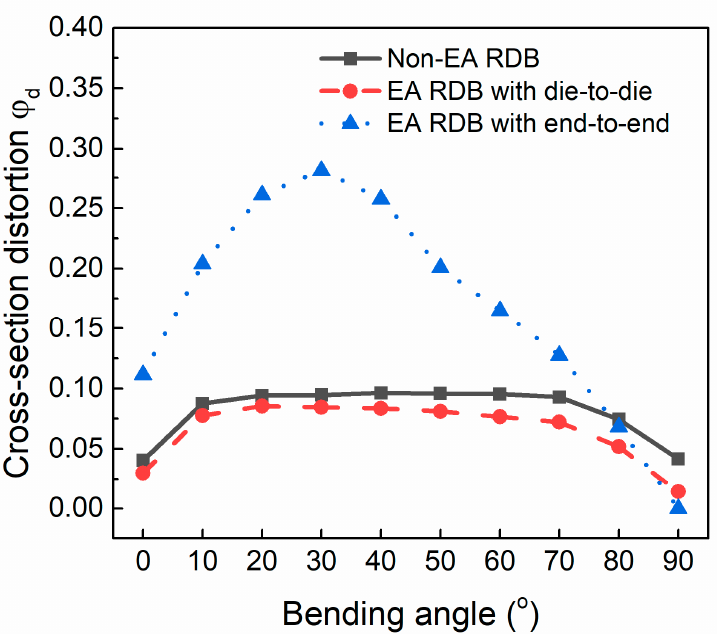
Figure 10. Cross section distortion at different bending angles of micro-tubes for different current passing configurations in RDB.